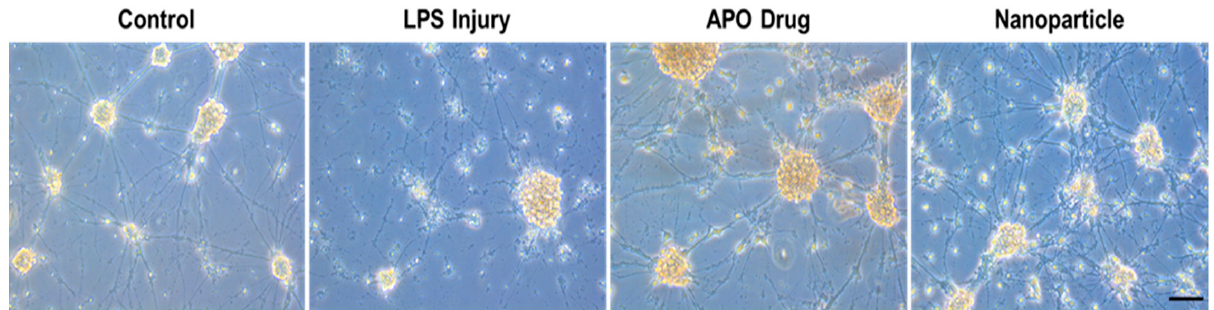
Figure 10. Effects of nanoparticle–apocynin conjugate treatment of injured neurons. Representative images of primary rat cortical neurons in the medium (control), after 48 h in 100 ng/mL of lipopolysaccharides (LPS injury) or 100 mM of apocynin (APO Drug), or in the nanoparticle–apocynin conjugate (nanoparticles) after 24 h of exposure to 100 ng/mL of lipopolysaccharides. The black bar represents 100 µ m (20 ×